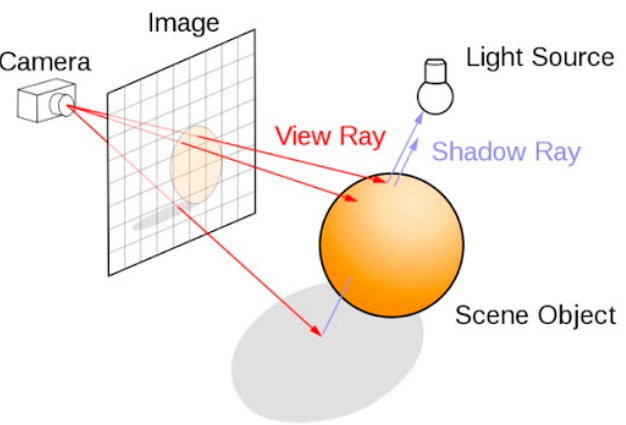
Figure 1. Simplified graphic representation of a lighting and shadowing method for rendering a 3D scene and how the final 2D image is generated [12].